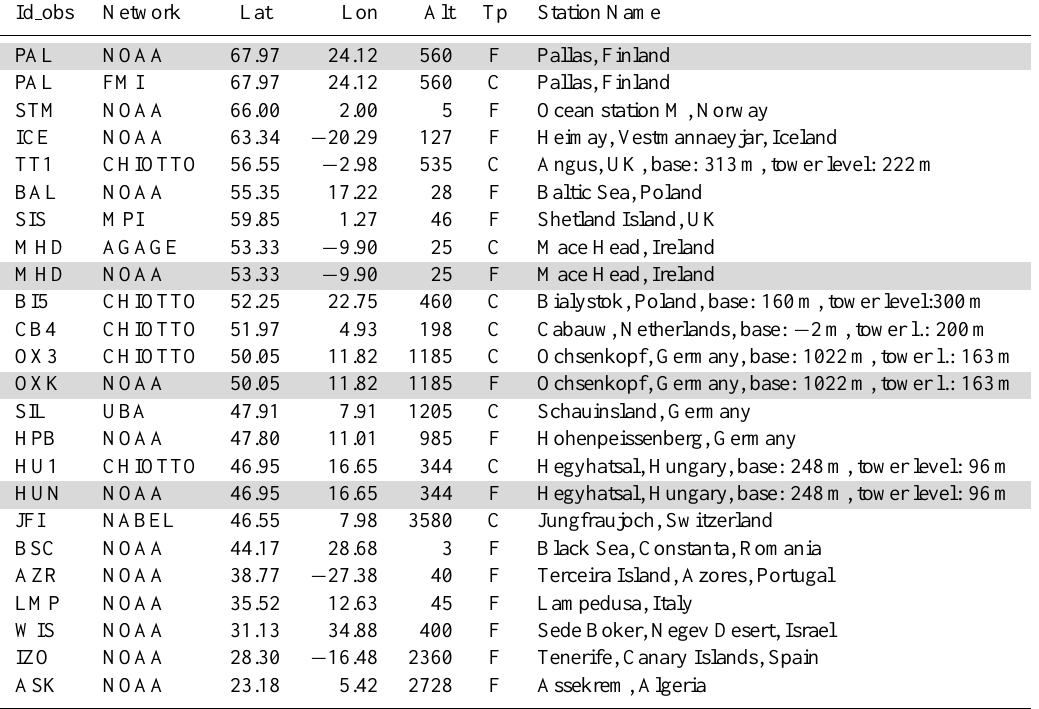
Table 1. List of stations used in the inversions. Only stations in the European zoomed domains are listed here (for the global stations see Fig. S1 in the Supplement). Latitude, longitude, altitude and type of sampling (Flask or Continuous) are listed. Stations with grey background are used in the inversion in all simulations but S4. Positive/negative latitudes and longitudes indicate north/south and east/west,